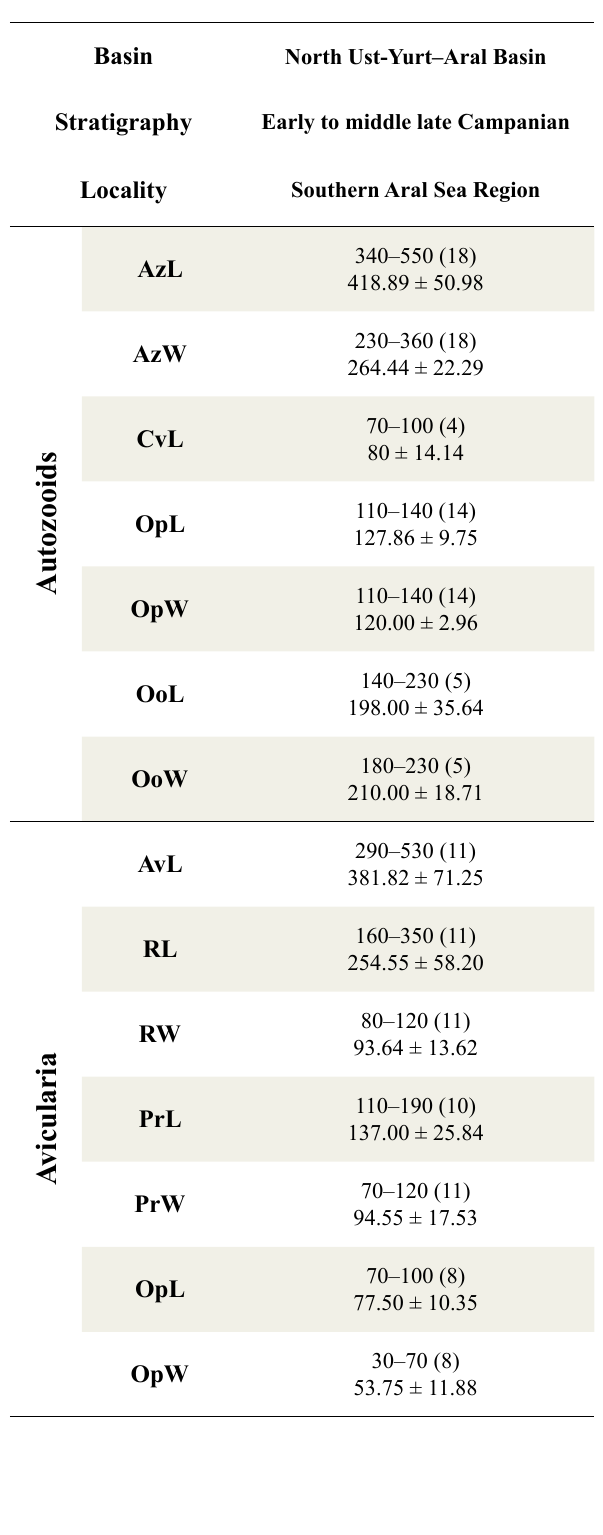
Table 9. Summary of measurements of Rhagasostoma tchvanovi (Favorskaya, 1992). For each parameter the range is given with the number of measurements in brackets. The arithmetic mean is given ± standard deviation. All measurements in